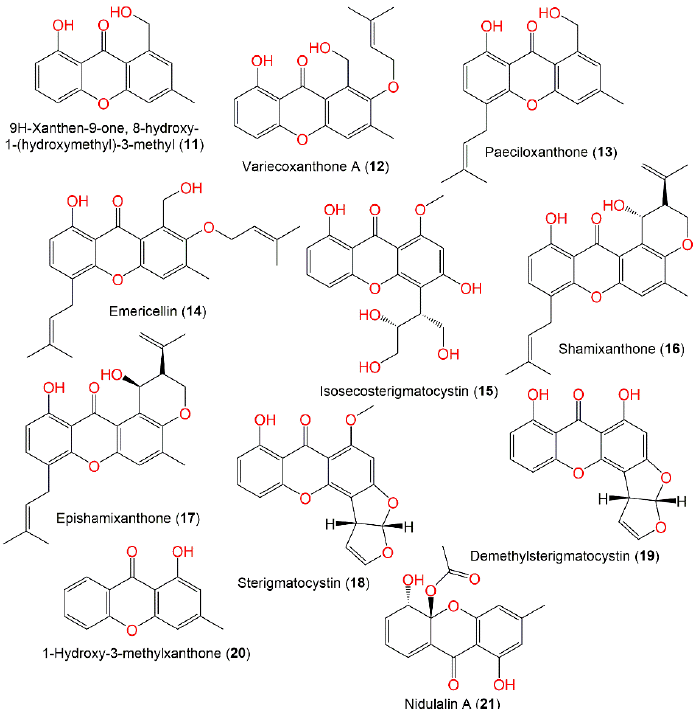
Figure 2. Structures of xanthones ( 11 – 21 ) reported from Aspergillus nidulans .